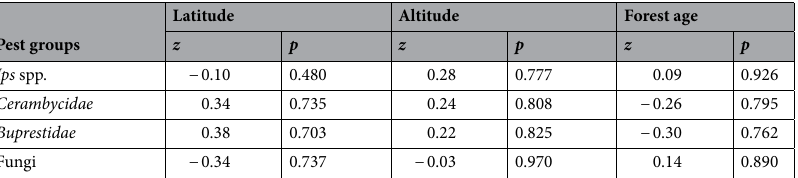
Table 1. The effect of latitude, altitude and the average forest age on the number of trees infected by wood boring beetles (Ips spp., Cerambycidae, Buprestidae) and fungi. The results are based on the GLMM models (negative binomial error distribution, maximum-likelihood fit).